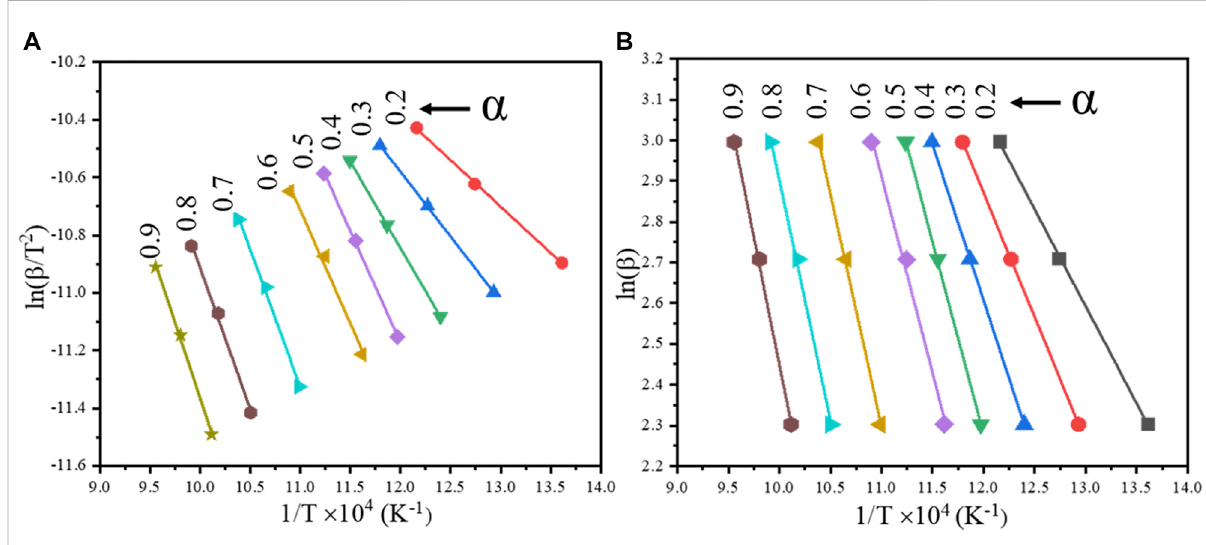
FIGURE 9 Linear fi tting curves of the cathode materials at different conversion rates by iso-conversional methods: (A) KAS model; (B) FWO model.